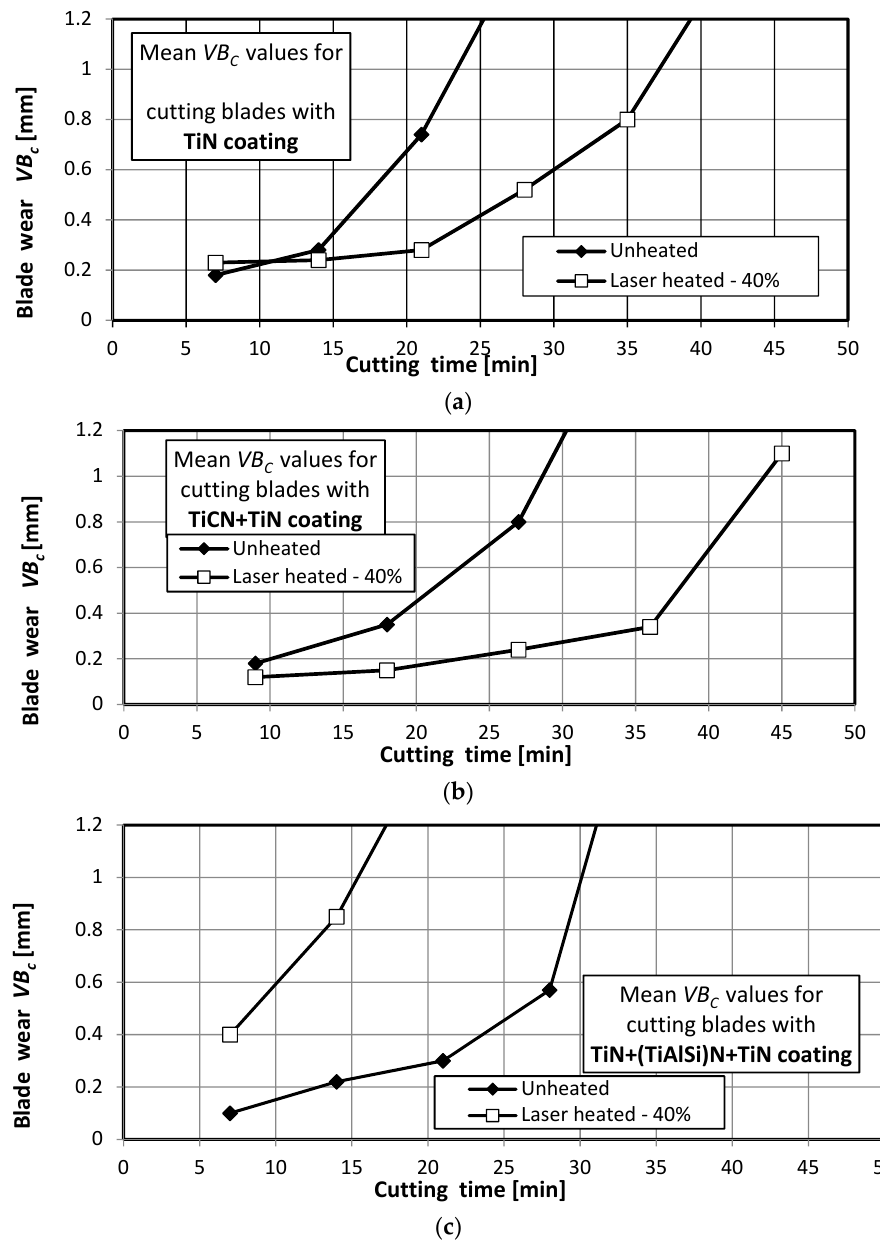
Figure 11. Examples of wear curves for the unheated and laser-heated (40% of the maximum laser power) SM25 sintered carbides cutting blades coated with ( a ) TiN, ( b ) TiCN + TiN, and ( c ) TiN + (TiAlSi)N + TiN, obtained in a turning process of 35HGS steel. The wear curves were used to determine the cutting tool life for a blade blunting indicator of VB c = 0.7 mm. Figure 12 shows the mean life of the SM25 sintered carbide cutting tool blades coated with TiN, TiCN + TiN, and TiN + (TiAlSi)N + TiN before and after laser heating with different laser power values, obtained in a turning process of 35HGS